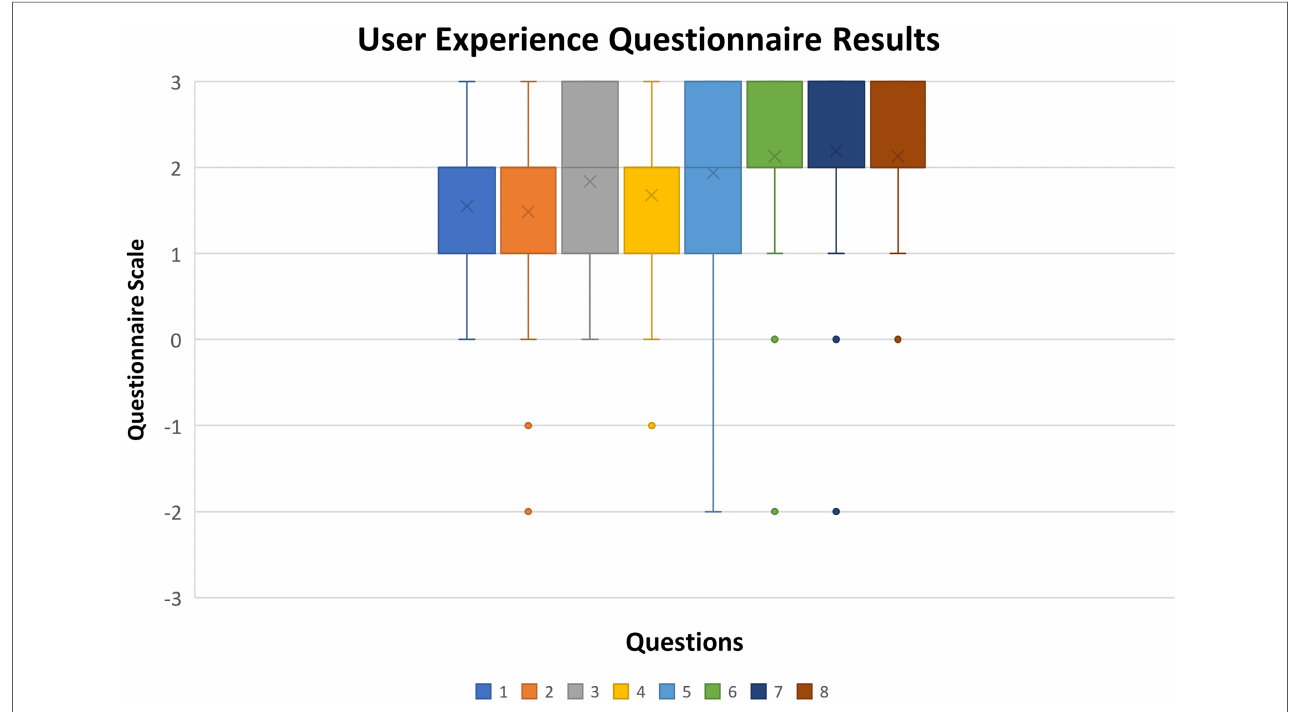
FIGURE 6 Boxplot chart of user experience questionnaire results (x stands for mean value, rectangle upper and lower quartile with at least 50% of values, whiskers represent the 0th and fourth quartile when there are